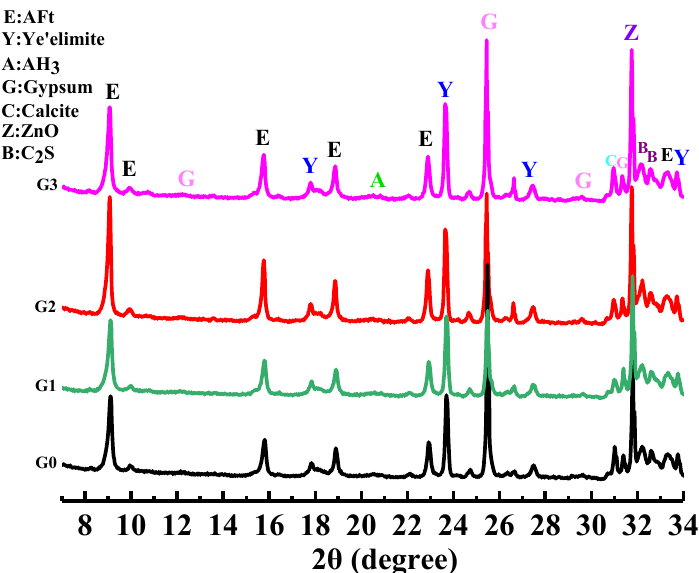
Figure 9. XRD analysis of sulfoaluminate cement paste.